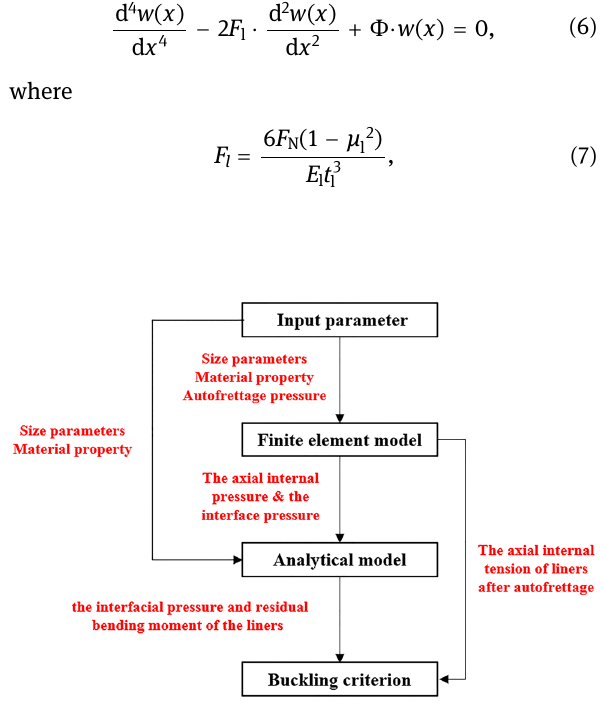
Figure 2: Calculation fl ow